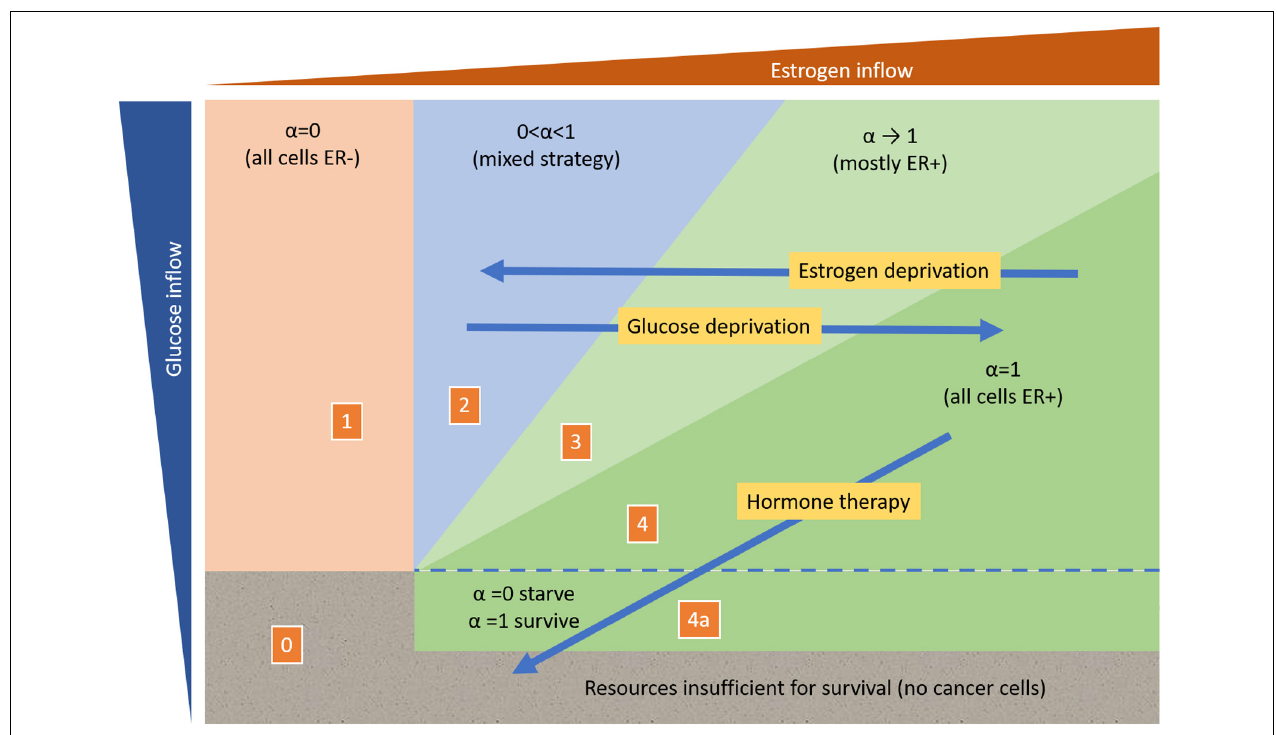
FIGURE 5 | Impact of possible resource-dependent intervention strategies on predicted tumor